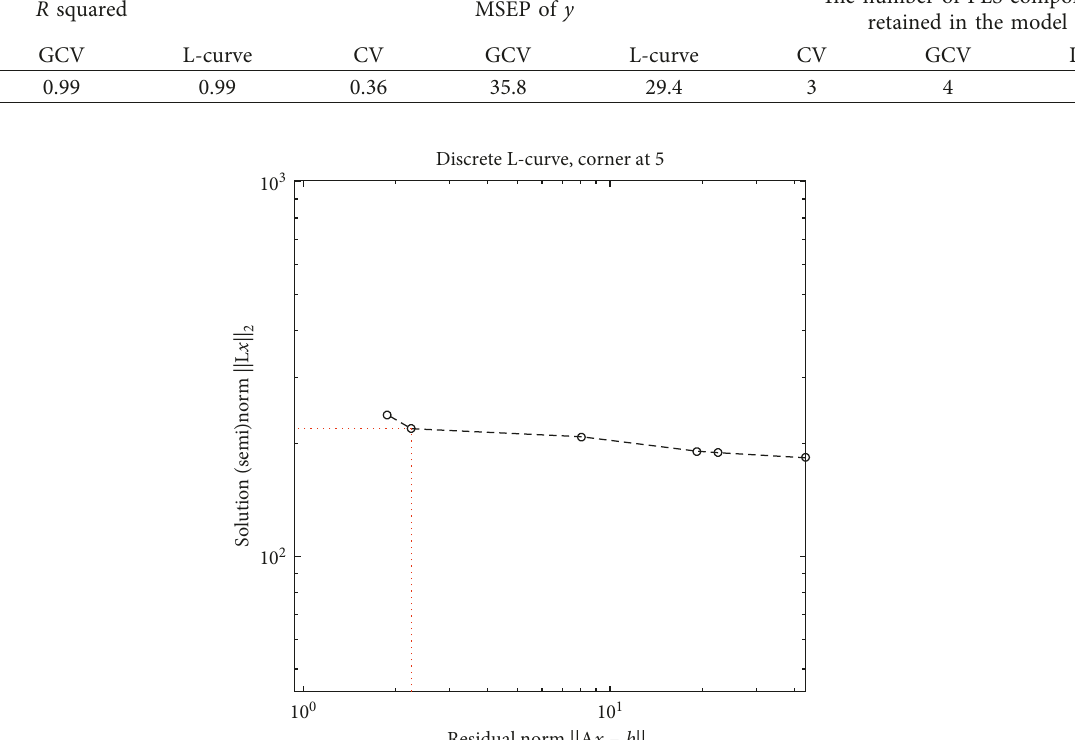
Table 2: The result of the comparison between cross validation (CV), generalized cross validation (GCV) and L-curve criterion on real data. R squared